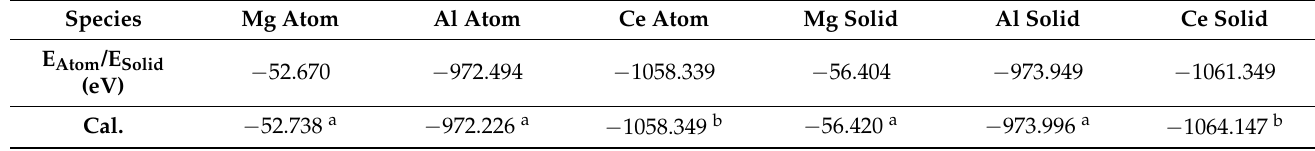
Table 3. The energy of atoms in a ground state and pure element solid.